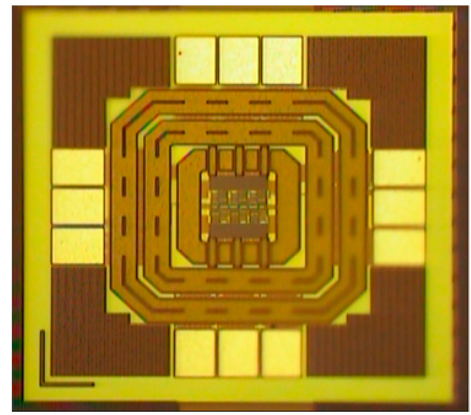
Figure 12. Microphotograph of the proposed VCO.